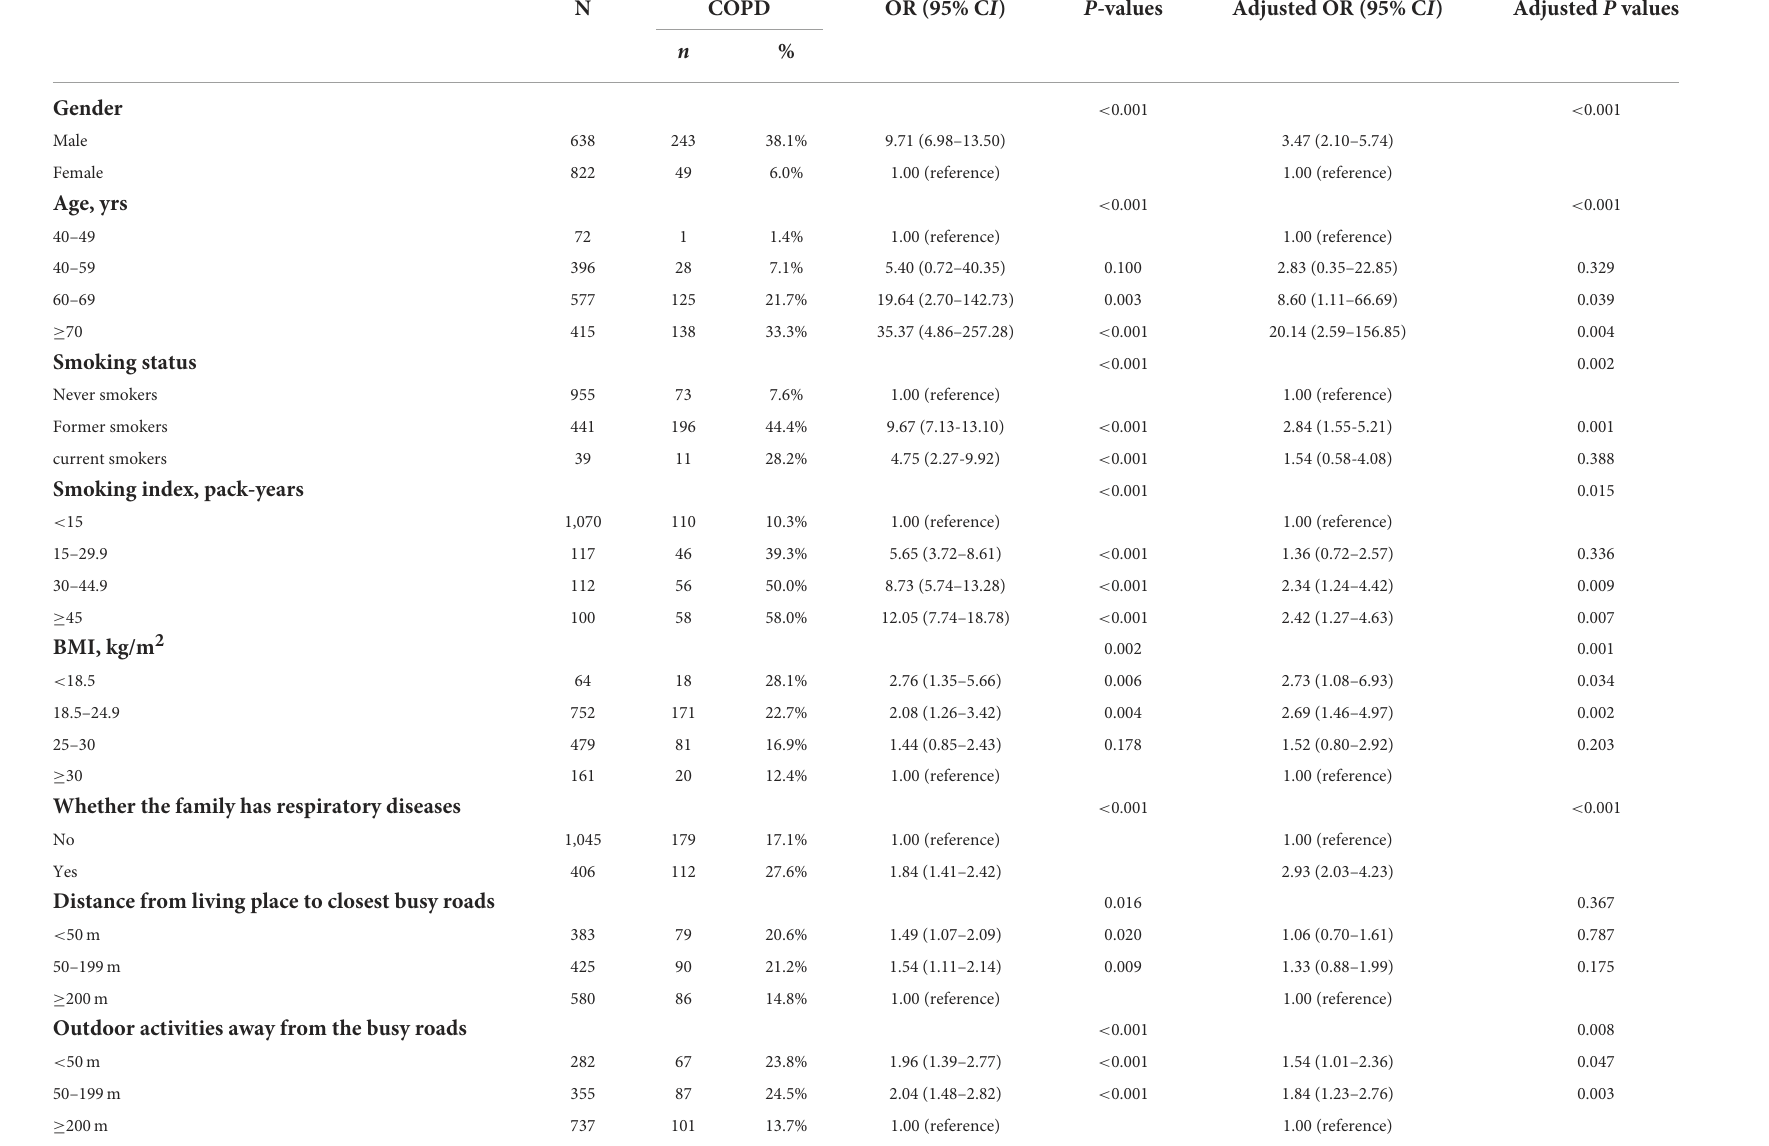
TABLE 1 Clinical characteristics and risk factors in patients with